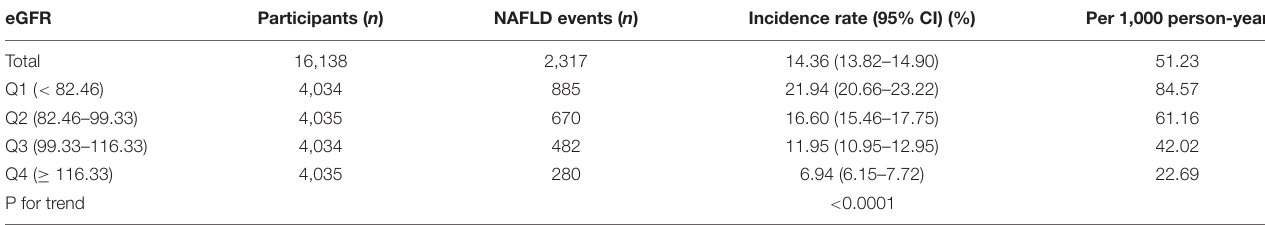
TABLE 2 | Incidence rate of incident NAFLD.